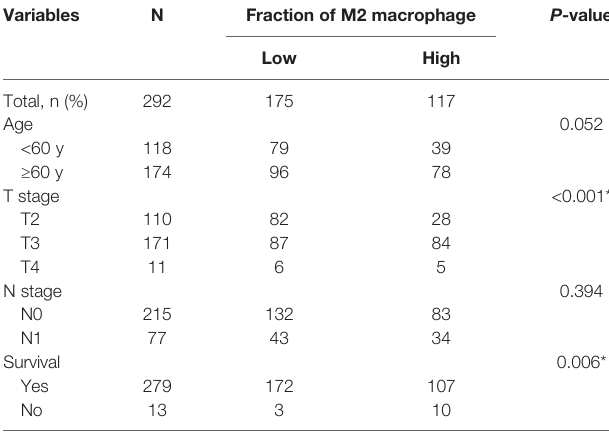
TABLE 1 | Clinicopathological characteristics of 292 patients with PCa from TCGA